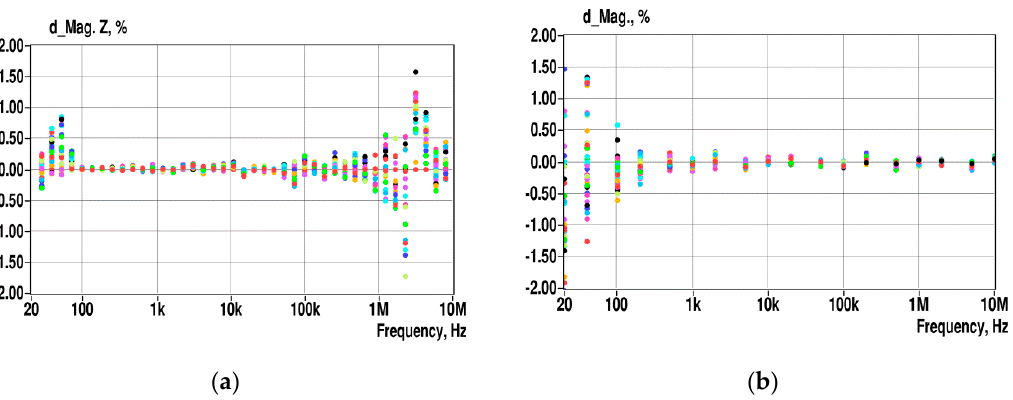
Figure A9. Impedance phases ( a ) of the SUT2, measured with the Wayne Kerr analyzer (WK), the developed analyzer (AN), and calculated from a computer model at the nominal values of its components. Deviations of phase values ( b ), measured with WK and AN, from the modeled results.